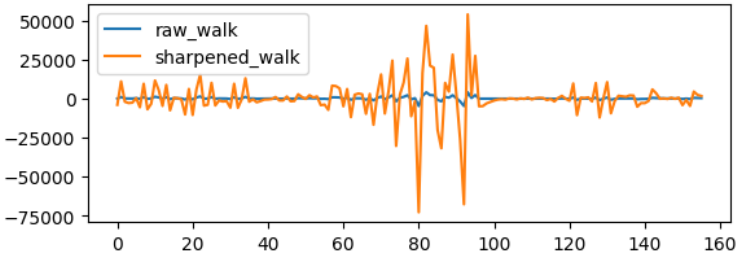
Figure 5. A sample activity data describing walking activity. Each number in the horizontal axis indicates various statistical features such as mean, standard deviation, minimum and maximum calculated from a fixed length time series data collected from multiple sensors. The blue line indicates data before sharpening and the orange line indicates data after